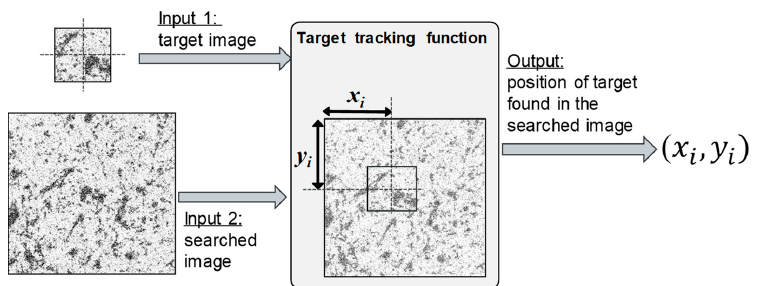
Figure 4. Input and output of a target-tracking function. Given target and searched images, a target tracking function returns the position where the target appears in the search image.